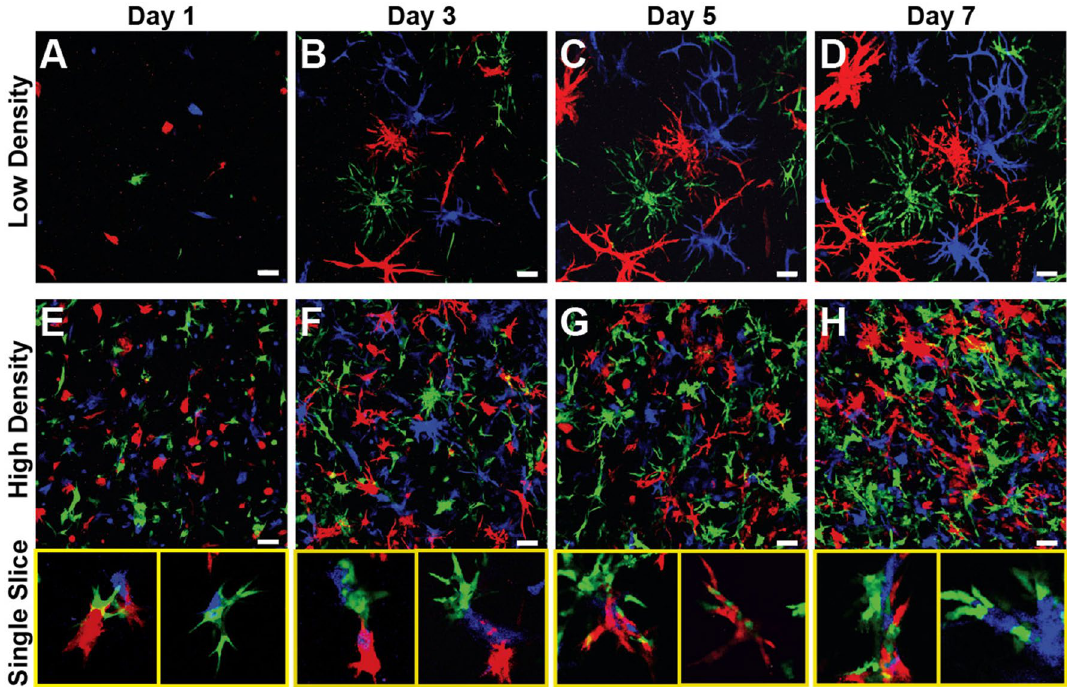
Figure 7. Duct Assembly Model Depends on Proximity. Multipoint imaging of low cell density (5e4 cells/ mL) cultures ( A – D ) and high cell density (1.5e6 cells/mL) cultures ( E – H ). Low density cultures show clonal branching from single cells suspended within the gel, while multi-colored structures are apparent in high density cultures after only a single day in culture because of their close proximity. Representative single z-slices of high density cultures indicate that structures composed of two or three colors are fairly common at all time points. Scale bars = 100